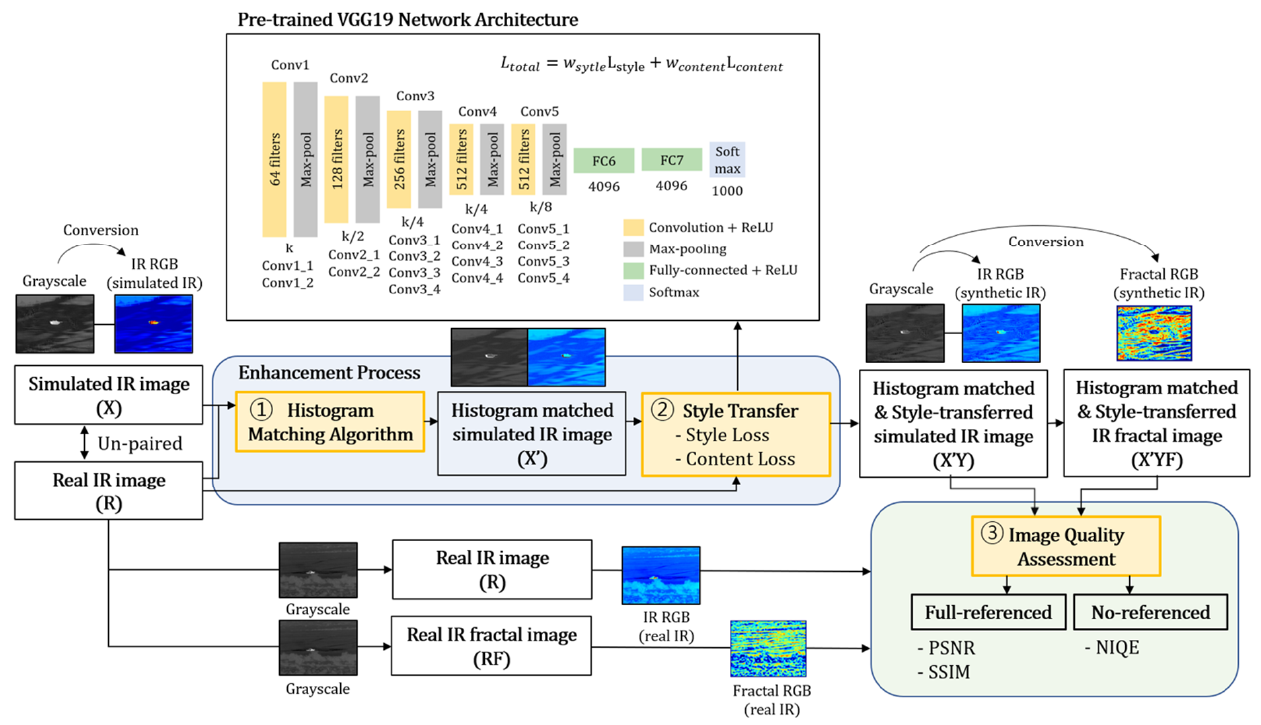
Figure 1. Flow chart of the proposed texture enhancement process of a simulated infrared image. The algorithm uses three infrared images to calculate the total loss: the histogram- matched simulated IR image X (cid:48) (input), the style-transferred simulated infrared image Y (output), and the real infrared image R (style). First, the input histogram-matched simulated infrared image ( X (cid:48) ) and the style-transferred infrared image ( Y ) are passed